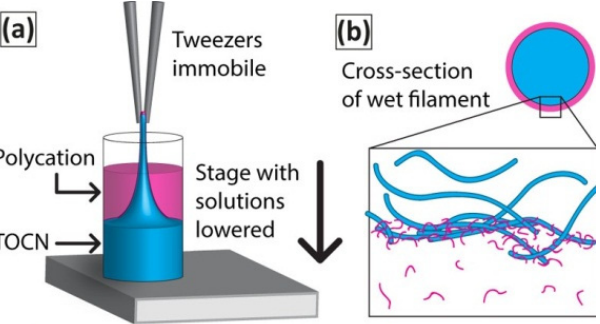
Figure 12. Schematic representation of ( a ) process of IPC of TOCN/polycation fibers, and ( b ) suggested cross-section of formed wet filament with polycation containing solution on the periphery and the formed polyelectrolyte complex membrane at the interface of the two fluids (Reprinted from reference Toivonen, M.S.; Kurki-Suonio, S.; Wagermaier, W.; Hynninen, V.; Hietala, S.; Ikkala, O. Interfacial Polyelectrolyte Complex Spinning of Cellulose Nanofibrils for Advanced